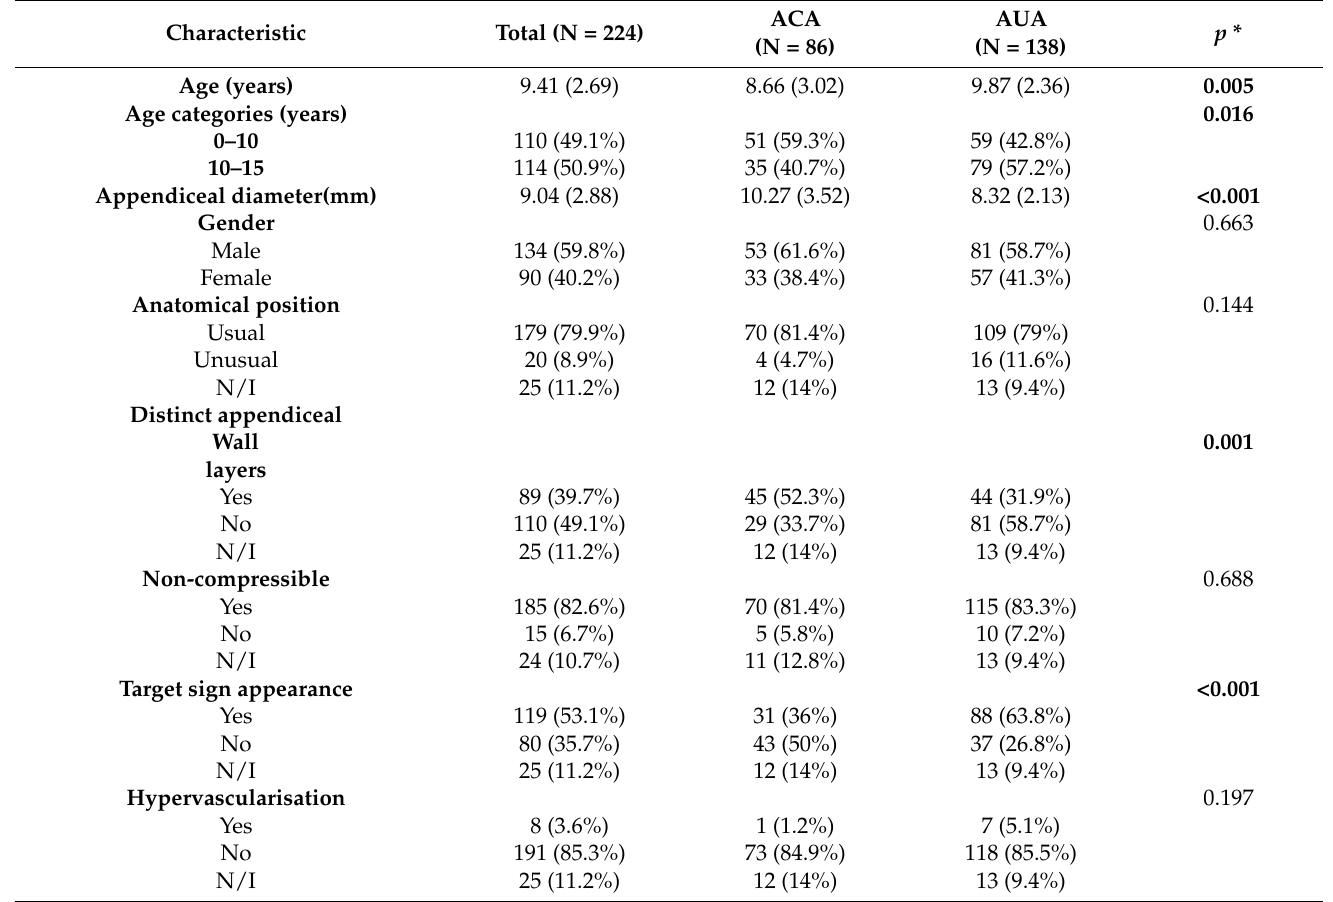
Table 1. Distribution of age, sex and US findings in total sample and by histopathological